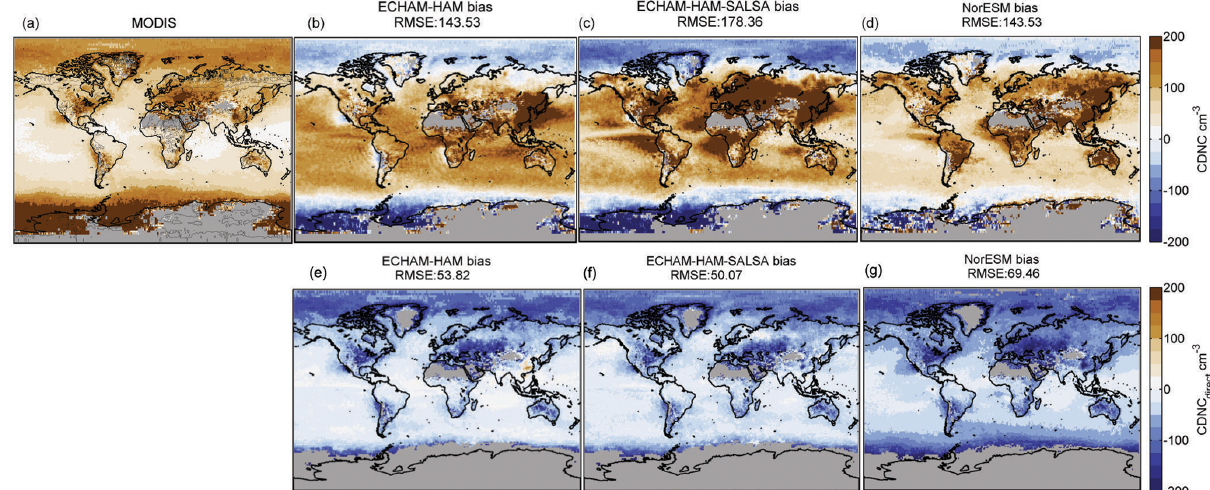
Figure 4. Cloud droplet number concentration (CDNC) annual mean bias. The bias represents the difference between CDNC derived from MODIS-COSP diagnostics and MODIS observations (b–d) and the model direct outputs and MODIS observations (f–h) . Pixels with liquid cloud fraction ≤ 30% are screened. The averages represent in-cloud values. High latitudes (lat > 60 ◦ N or lat > 60 ◦ S) are excluded in the computation of the root mean square error (RMSE). MODIS spatial distribution is presented as reference (a) . Contour lines highlight the land areas where the assumptions for deriving MODIS CDNC are less